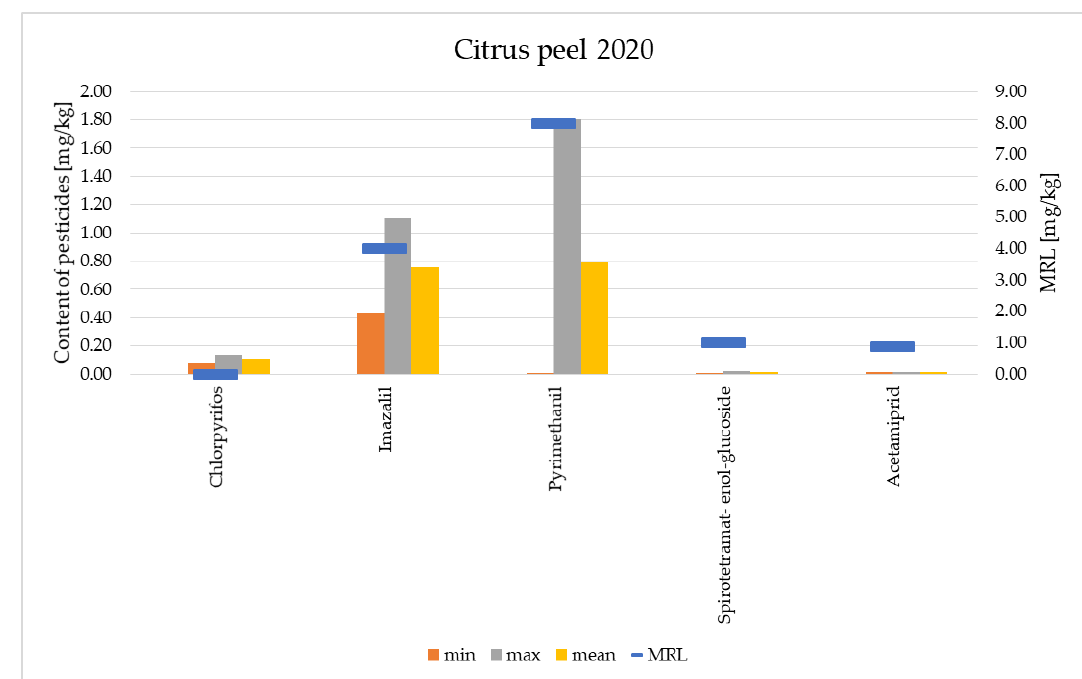
Figure 14. Content of pesticides in peels of citrus fruits from the harvest of 2020. Table 2. Occurrence of individual pesticides in citrus fruits and the values of MRL.